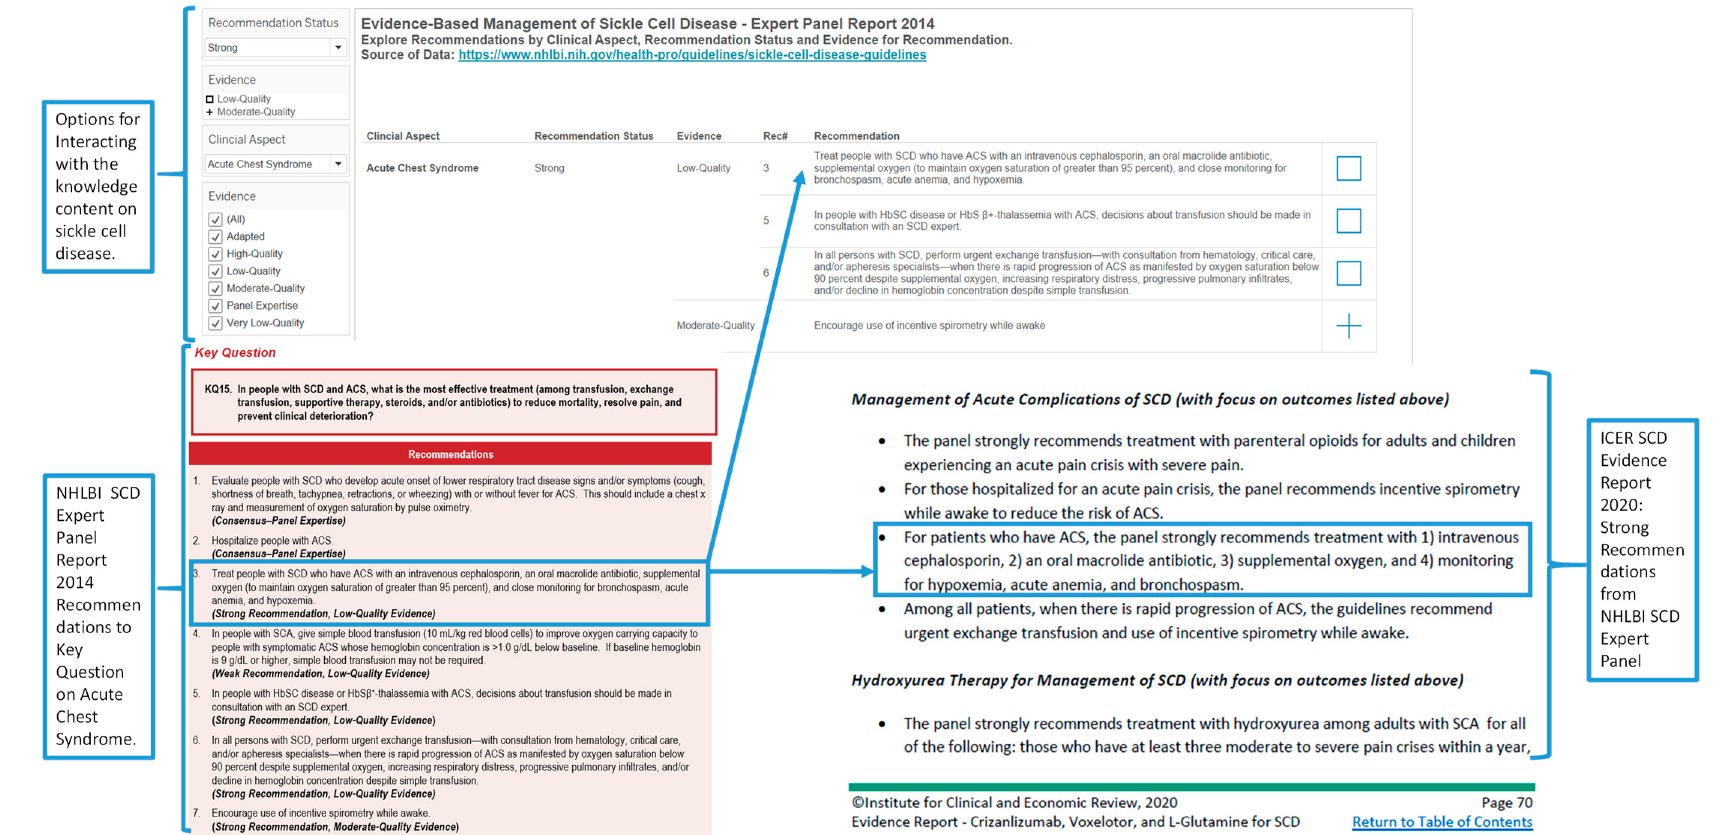
Figure 11. A validation of content of the interactive analytics resource for exploring recommendations on evidence ‐ based management of sickle cell disease. The interactive analytics resource enables interactions to support decision making on the clinical aspects of sickle cell disease and associated recommendations and evidence. The example is for acute chest syndrome, one of the most common and serious complications of sickle cell disease.